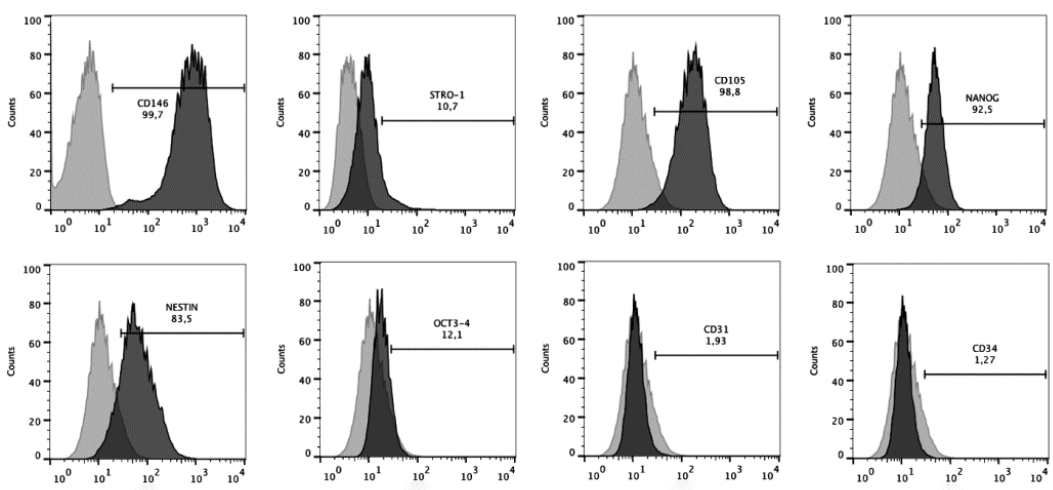
Figure 2. hMSCs characterization immunoprofile of dental pulp stem cells. Positive expressions of CD146, STRO-1, CD105, Nanog, Nestin, and Oct3 / 4, and negative or minimum expression of CD31 and CD34.